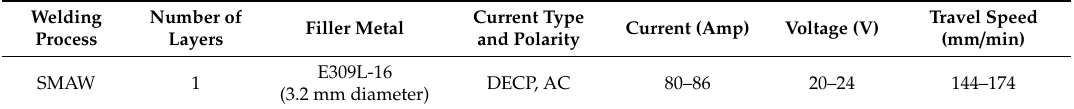
Figure 3. The schematic of the cladding process: ( a ) Shielded metal arc welding (SMAW); ( b ) A36—A36 welded substrate; ( c ) Hard facing overlay; ( d ) Grinding; ( e ) Cladding surface.